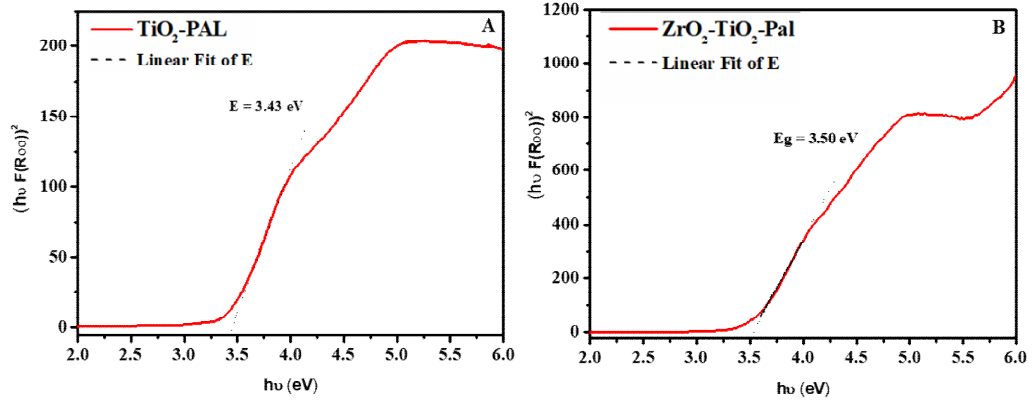
Figure 5. Kubelka–Munk curves of the ( A ) TiO 2 –Pal and ( B ) ZrO 2 –TiO 2 –Pal composites.